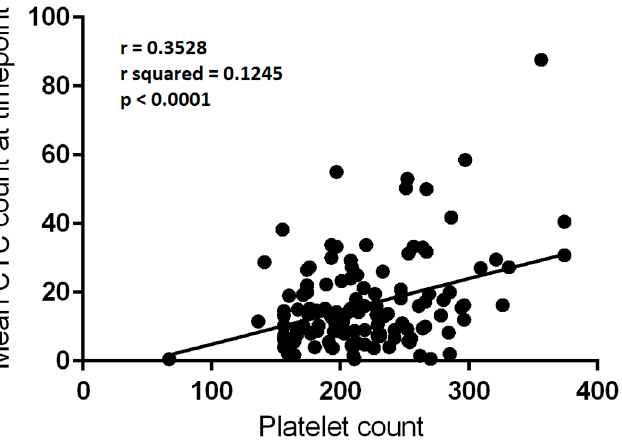
Figure 5. Correlation between platelet count (×10 9 /L) and mean circulating tumour cell (CTC) count per 3 mL of blood at a given blood draw which lacked platelet-cloaking ( n = 128). Linear regression, r = 0.3528; r 2 = 0.1245; p < 0.0001.